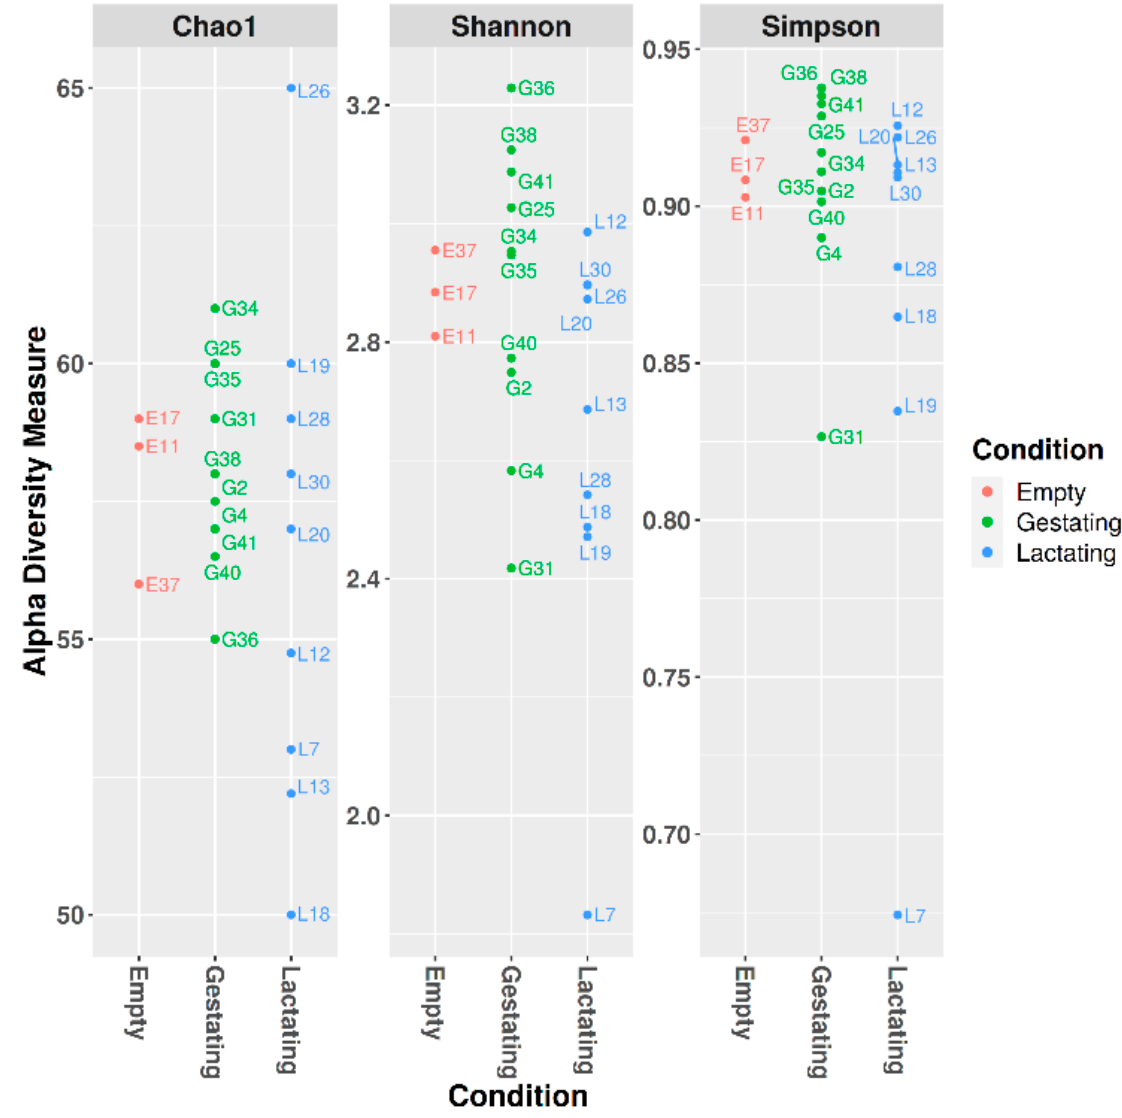
Figure 2. Alpha diversity based on the Chao1, Shannon, and Simpson indices.